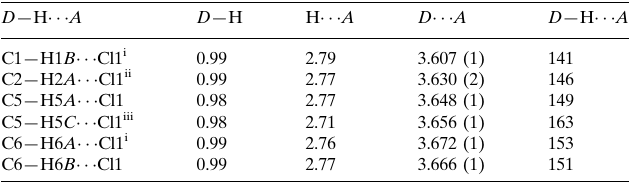
Hydrogen-bond geometry (A˚ , (cid:4)